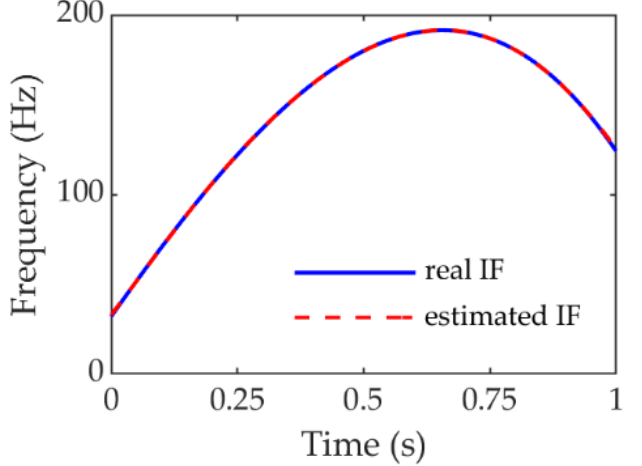
Figure 9. The rotor test rig.